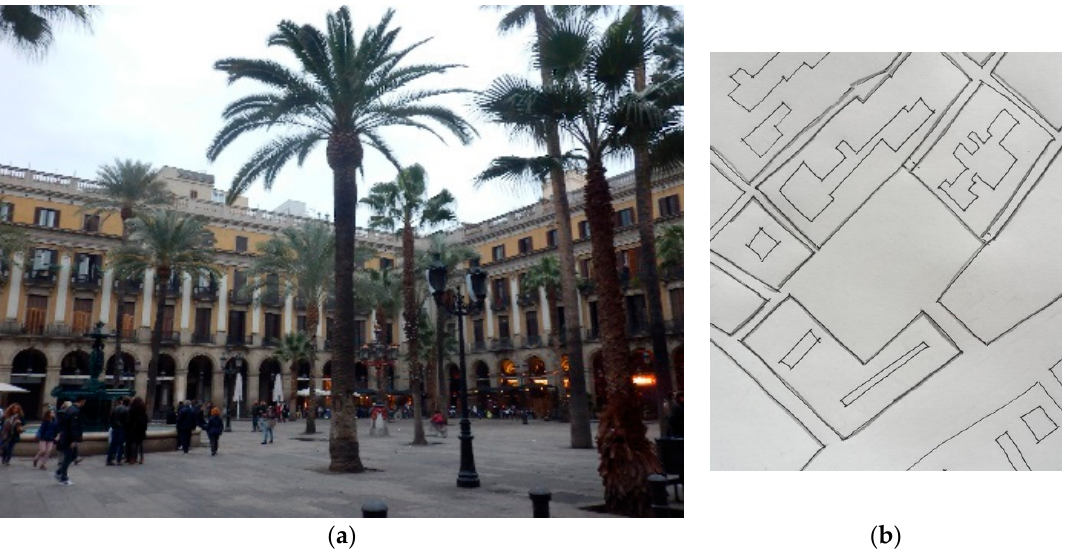
Figure 1. Example of a design pattern provided to the students when dealing with the design task. ( a ) Perspective view. ( b ) Plan view Photography by